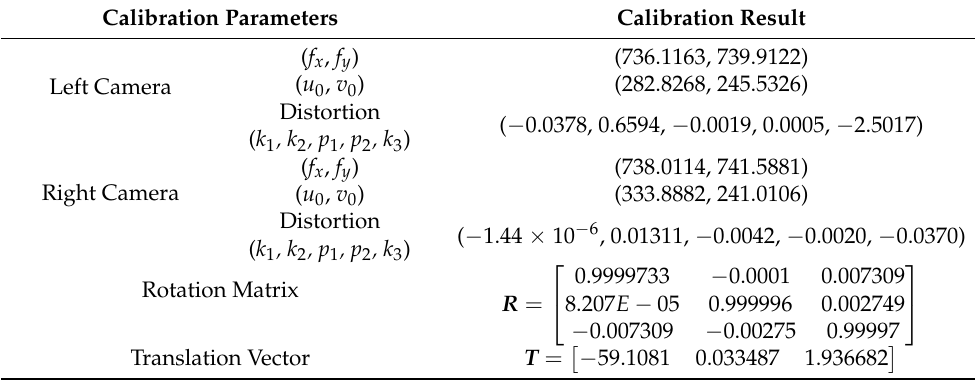
Figure 11. The images of the calibration board acquired by the right camera. Table 1. The calibration results of the